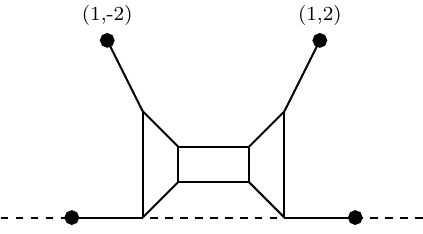
Figure 14. 5-brane web diagram for SO(4) 2 π, 2 π